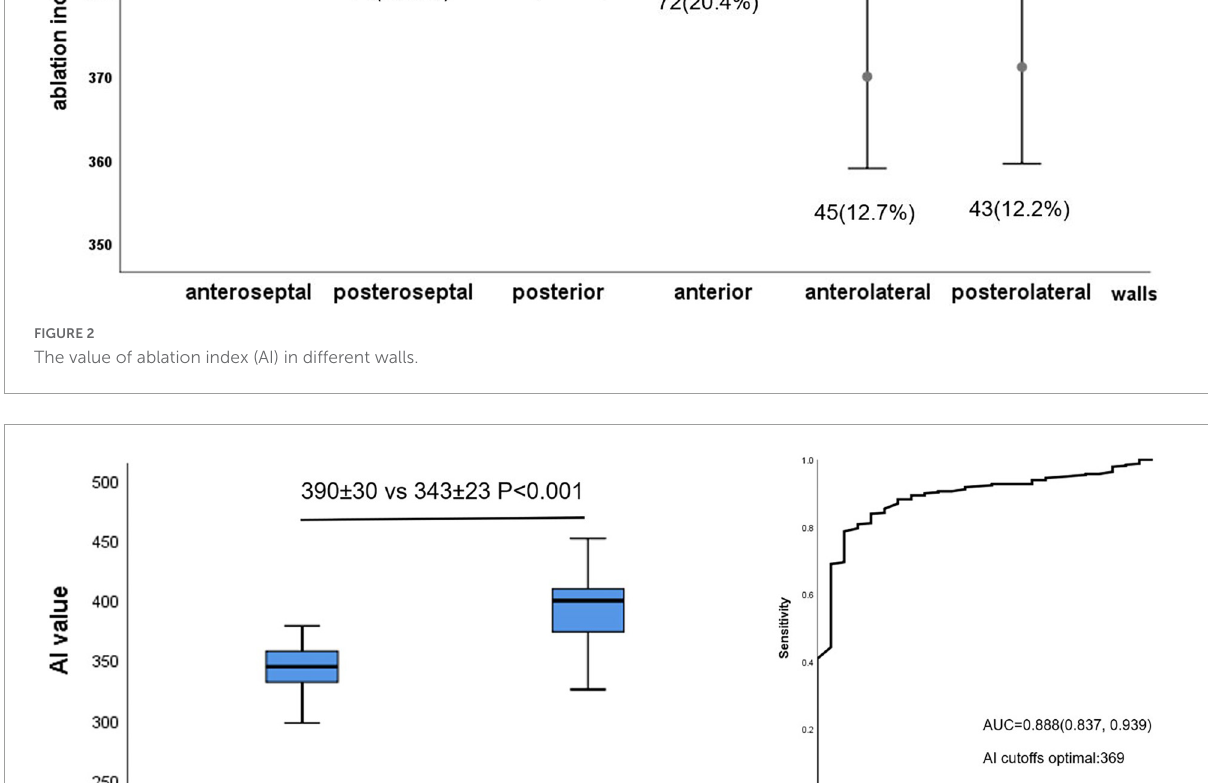
FIGURE3 Relationship between AI value and acute block after first-pass encirclement. Mean AI value in acutely blocked and no-blocked sites (Left) and corresponding ROC curve analysis (Right)